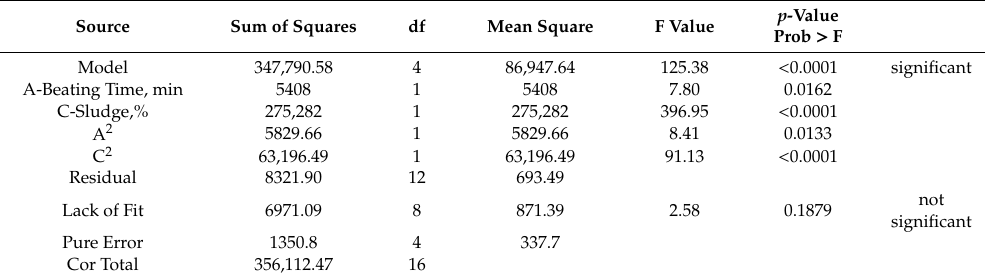
Table 11. ANOVA table for biogas production by AD of pot ale quadratic model α = 0.05.